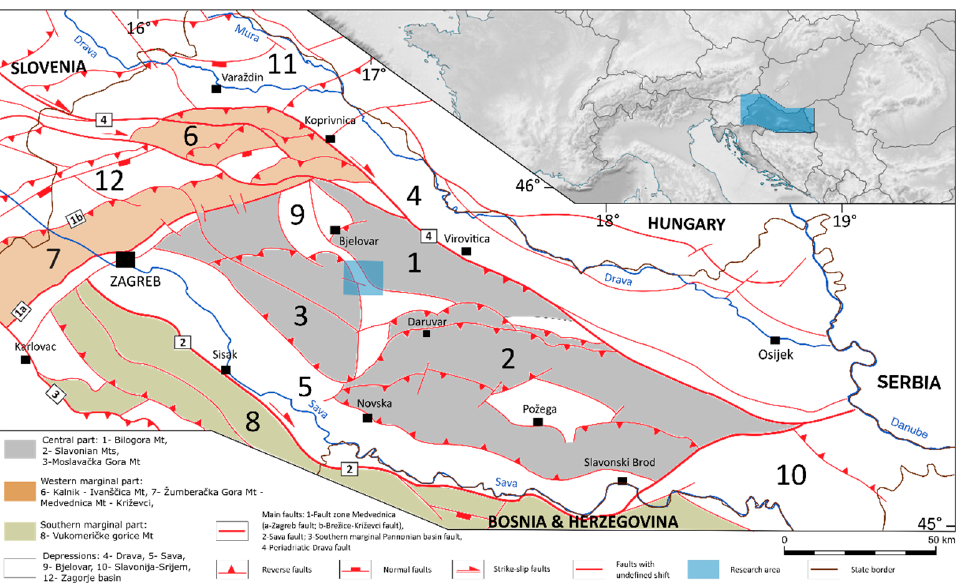
Figure 1. Location map of the research area showing Bjelovar Depression on tectonic map with major tectonic units of N and NW Croatia (modified after [24]).